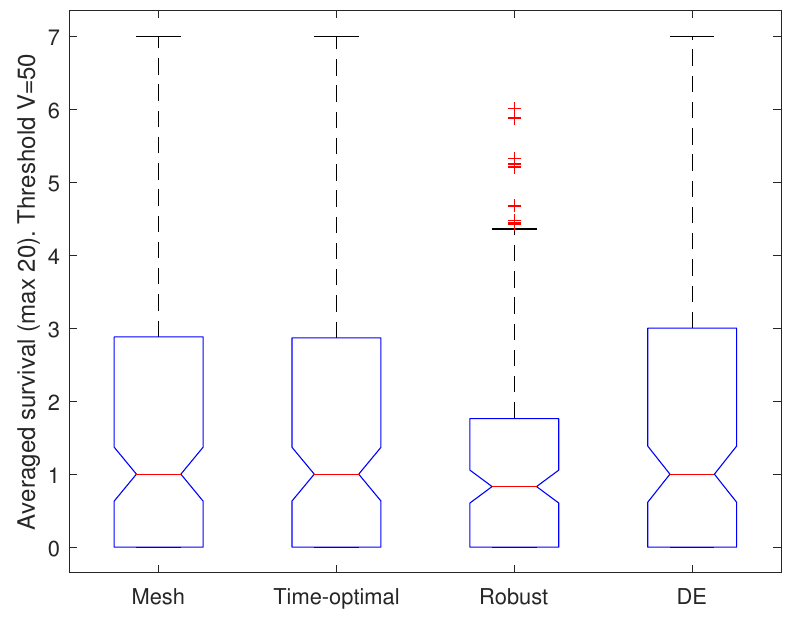
Figure 5. Boxplot of the results obtained in